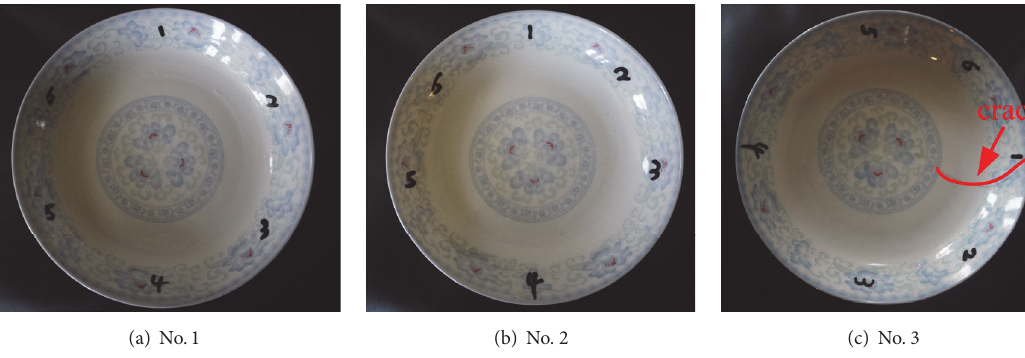
Figure 2: Three ceramic plates for the test.